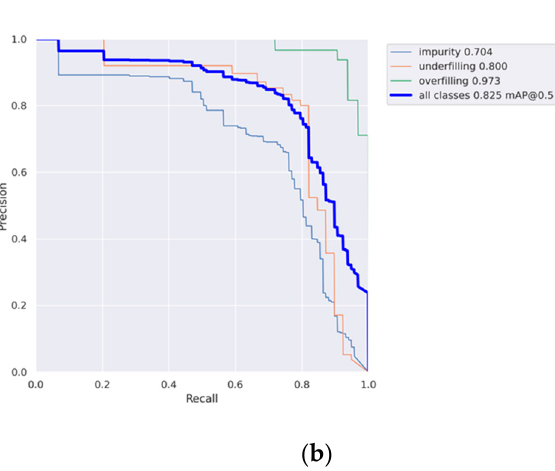
Figure 8. ( a ) Confusion matrix, ( b ) Precision vs. Recall Curve .